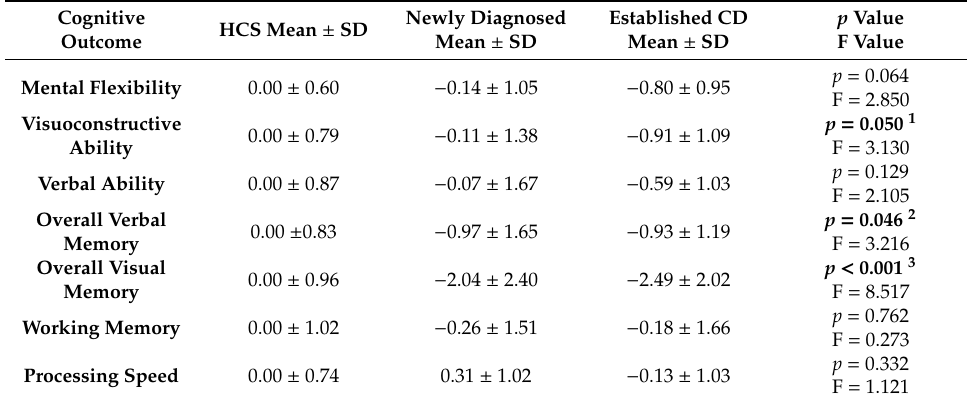
Table 2. Results of groups comparisons (ANCOVAs, controlling for age) on the cognitive domain scores.